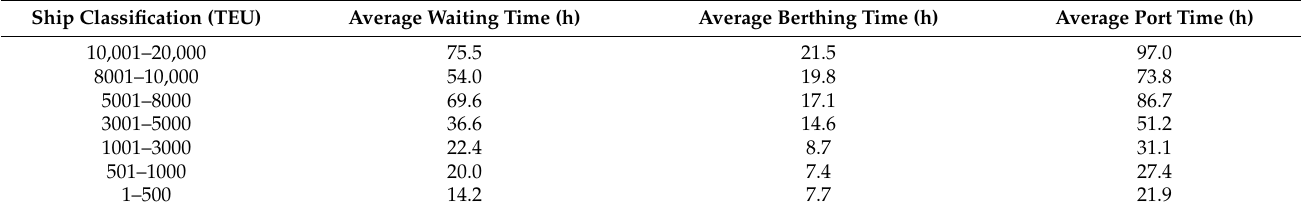
Table A3. Average port time depending on ship